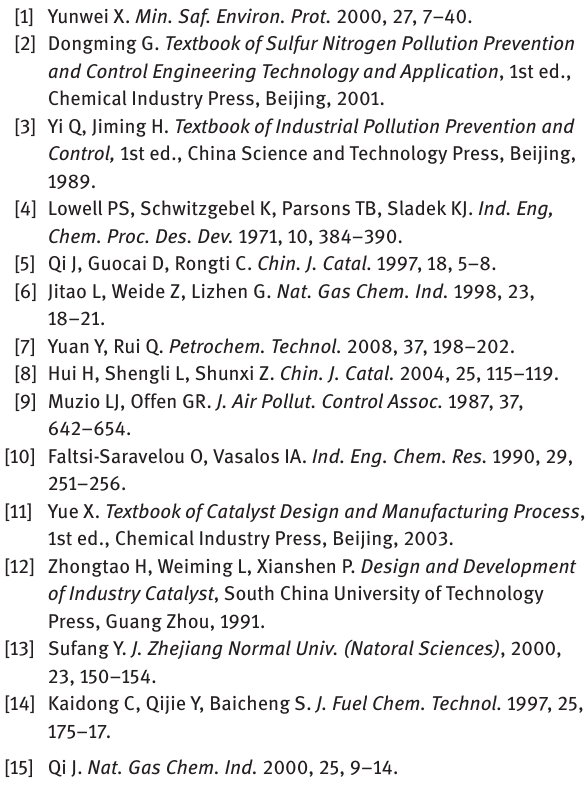
Figure 7: The TRP spectrogram of the bimetallic catalyst MnO -NiO/ γ -Al O 2 2 3